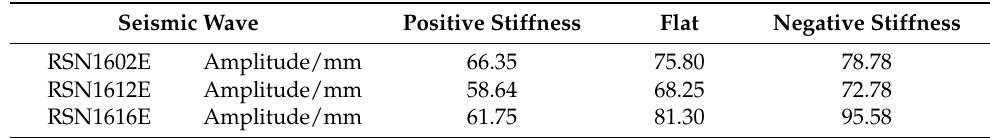
Figure 22. Time-history curve of bearing displacement under the action of near-field vibration. Table 1. The displacement amplitude and damping rate of the bearing under the action of near-field